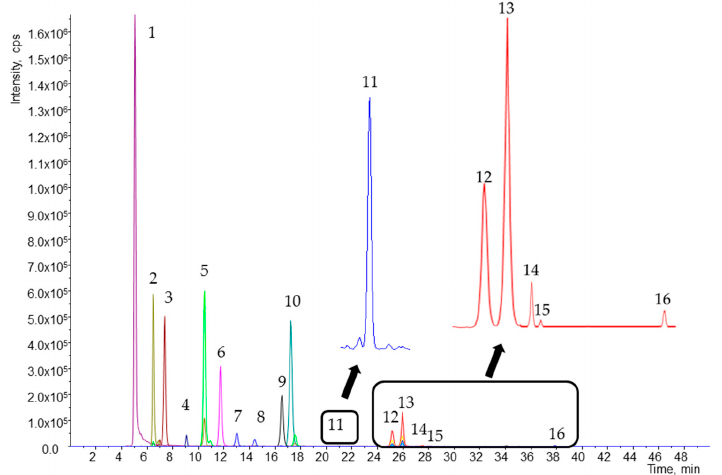
Figure 1. Chromatogram of working standard solutions obtained by high pressure liquid chromatography-tandem mass spectrometry (HPLC-MS/MS) analysis. Peaks: ( 1 ) retinol;